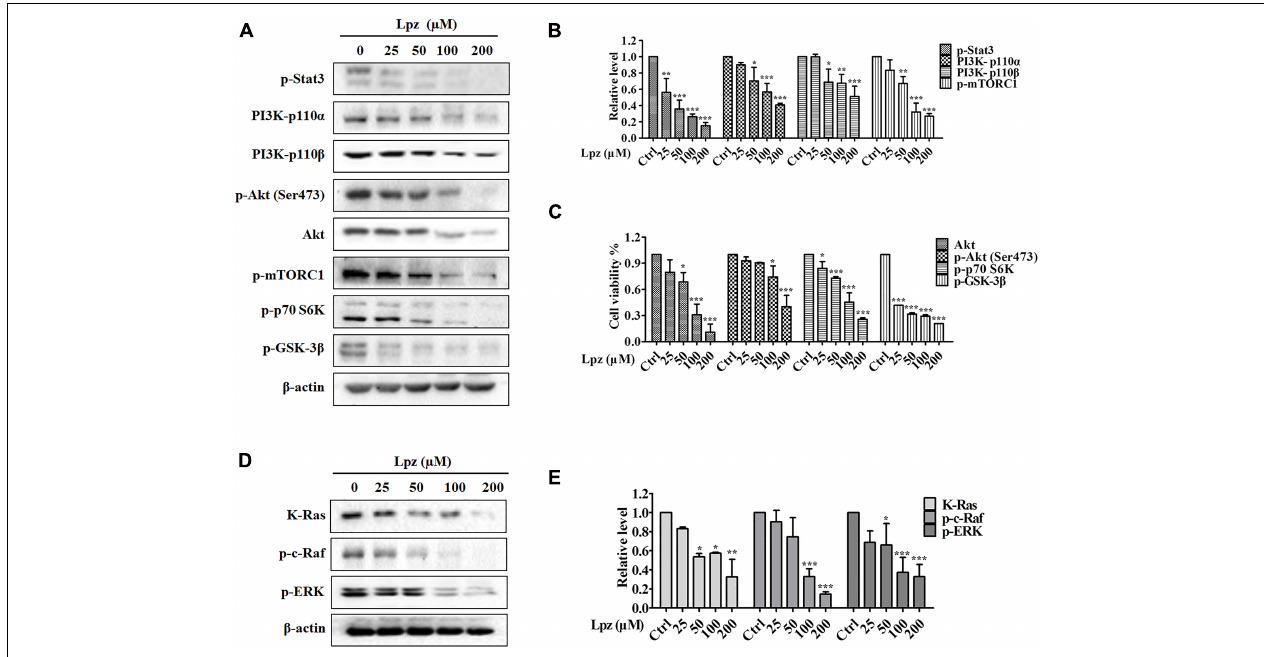
FIGURE 3 | Lansoprazole inhibits phosphorylation of the Stat3, PI3K/Akt/mTOR, and Ras/Raf/ERK pathways. (A) Lpz downregulated the phosphorylation of Stat3, Akt, mTOR, p70 S6K, and GSK-3 β and the expression of PI3K. (B,C) Quantification of the results in panel (A) . (D) Lpz suppressed the expression of K-Ras and the phosphorylation of c-Raf and ERK. (E) Quantification of the results in panel (D) . Data shown are the mean ± SD of three independent experiments. *: p < 0.05, **: p < 0.01, and ***: p < 0.001.